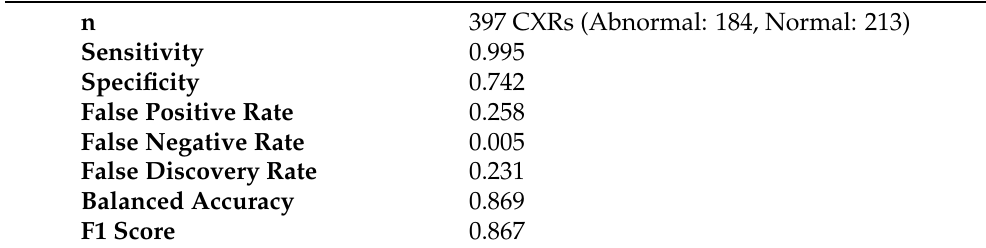
Table 1. Performance of DLAD during internal